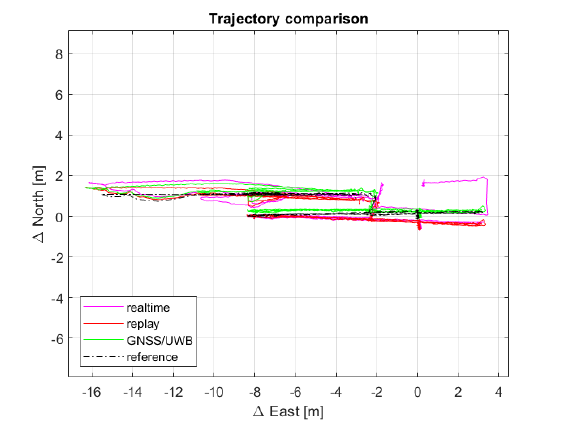
Figure 10. The X-Z view trajectory estimation comparison between real-time, replay and GNSS/UWB solutions.